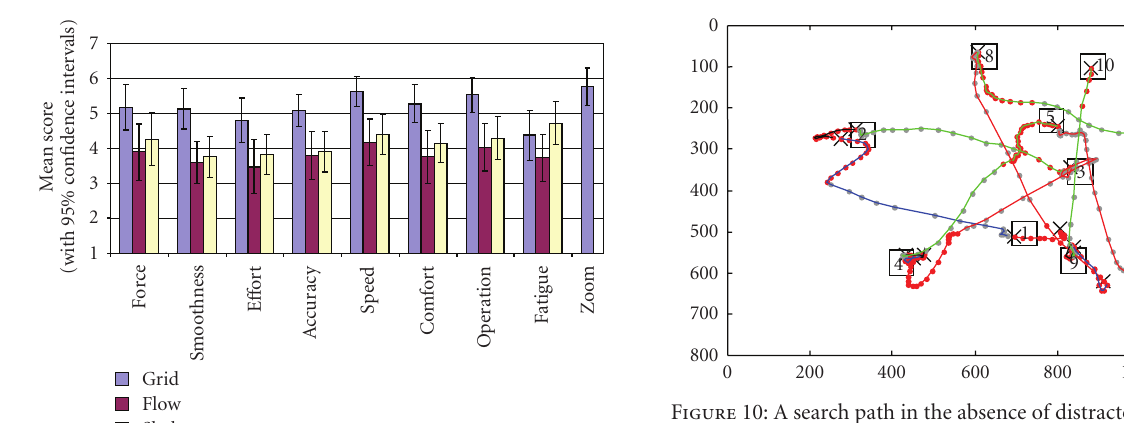
Figure 10: A search path in the absence of distractors using halos.